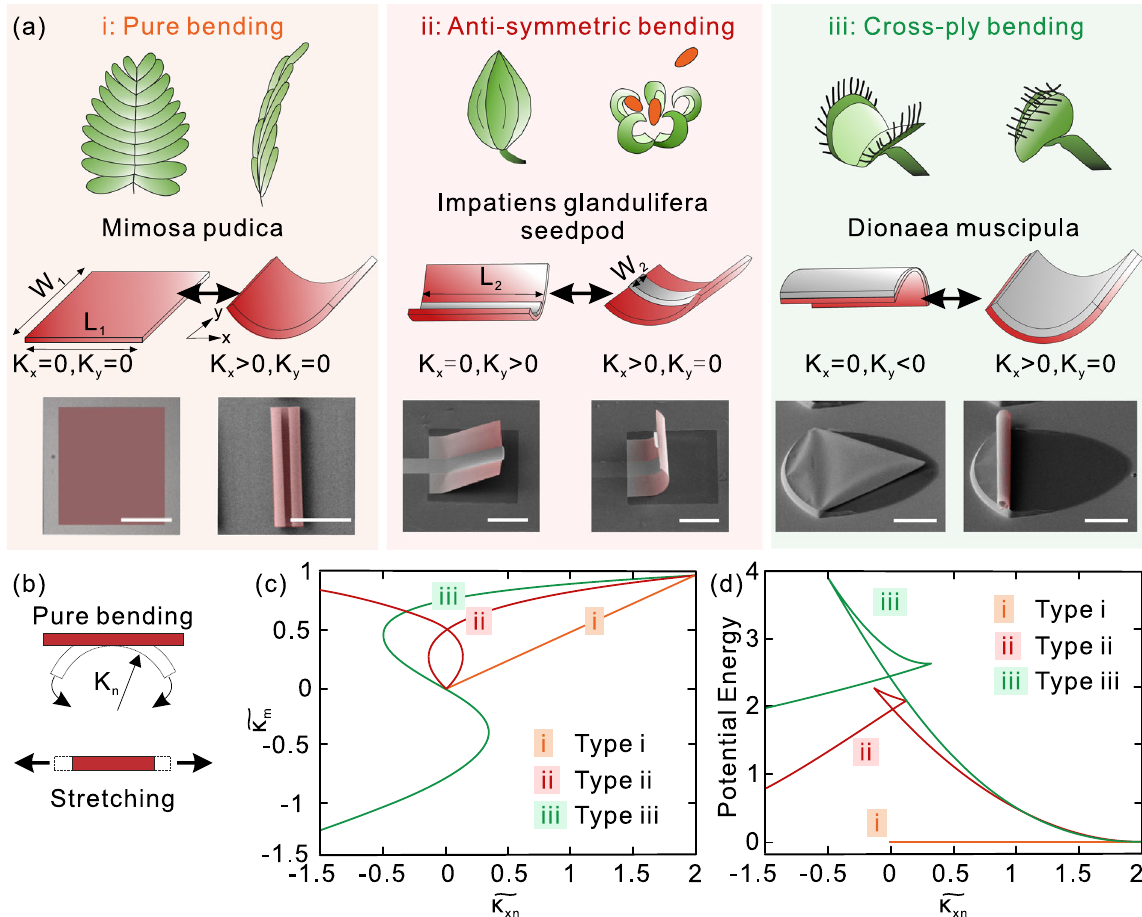
Fig. 1 Gaussian-preserved shape morphing in plants and man-made microstructures. a A conceptual overview of three types of Gaussian-preserved shape morphing in plants (upper panel), man-made recon fi gurable microstructures (middle panel), and corresponding SEM images (lower panel): (i) pure bending, (ii) anti-symmetric bending, and (iii) cross-ply bending. K x and K y are the curvatures of nanomembranes in x - and y -direction, respectively. W 1 and L 1 are the width and length of nanomembranes, respectively. W 2 and L 2 are the width and length of creases, respectively. The scale bar is 50 μ m. b The schematic diagram of bending and stretching. K n is nature curvature. c Geometric change with respect to natural curvature for three types of morphing. Orange line, red line, and green line present pure bending type, anti-symmetric bending type, and cross-ply bending type, respectively. It is observed that both type ii and iii situation allows two minimum in the shape-morphing process. d Potential energy with respect to natural curvature. The energy barrier of type ii and iii can lead to a non-volatile recon fi